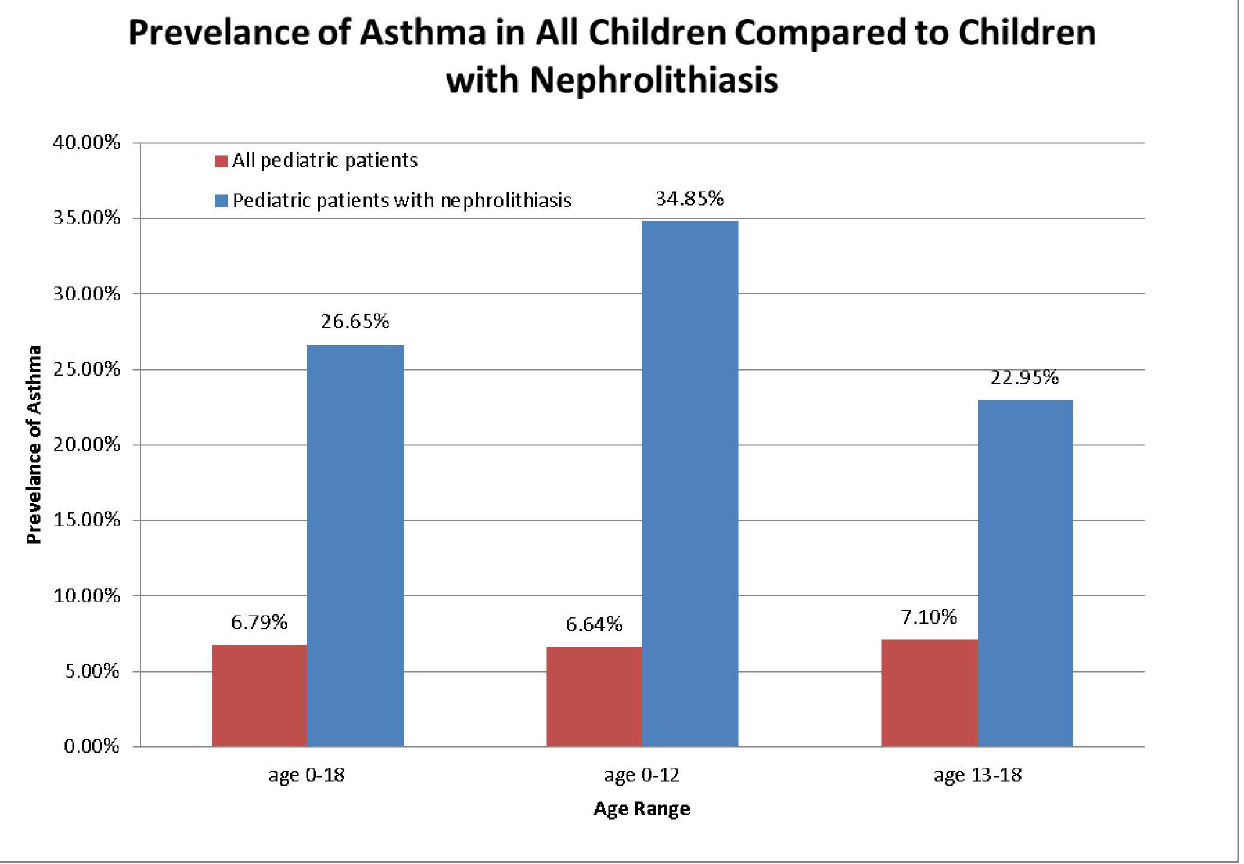
Fig 1. The prevalenceof asthma at our institution in all children and children with nephrolithiasis.